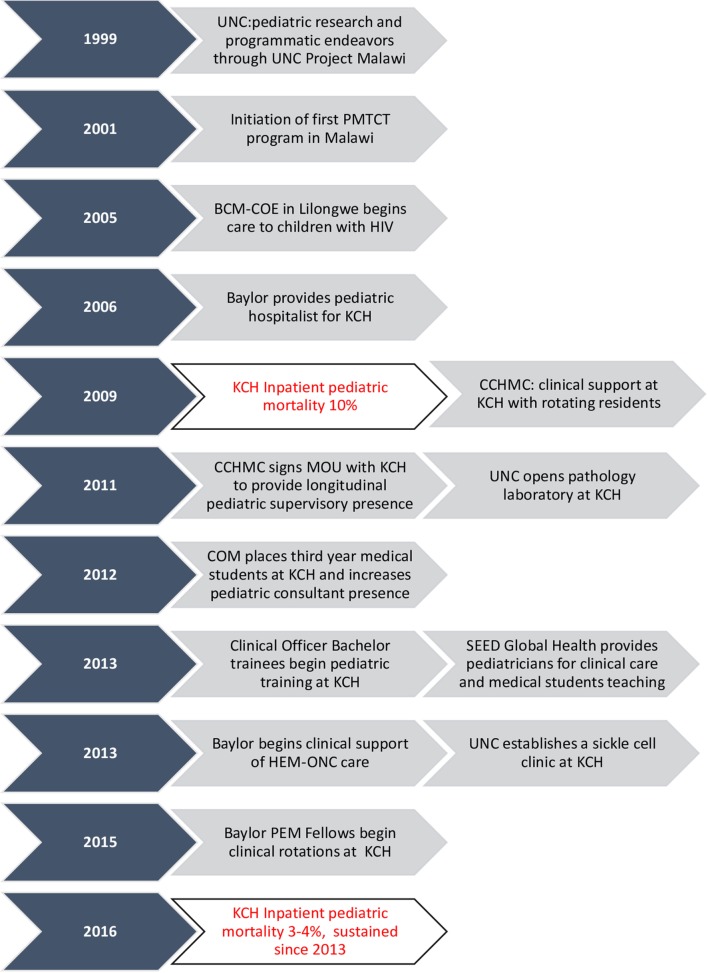
Timeline of institutional activities at Kamuzu Central Hospital.